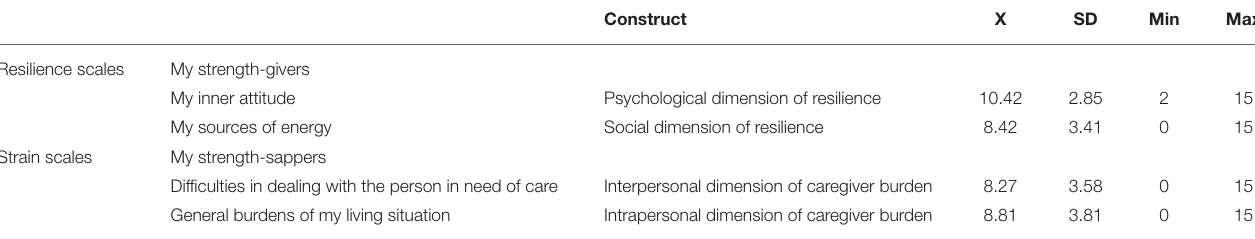
TABLE 2 | Overview of Scales assessed by ResQ-Care and X, SD, Min, and Max based on study